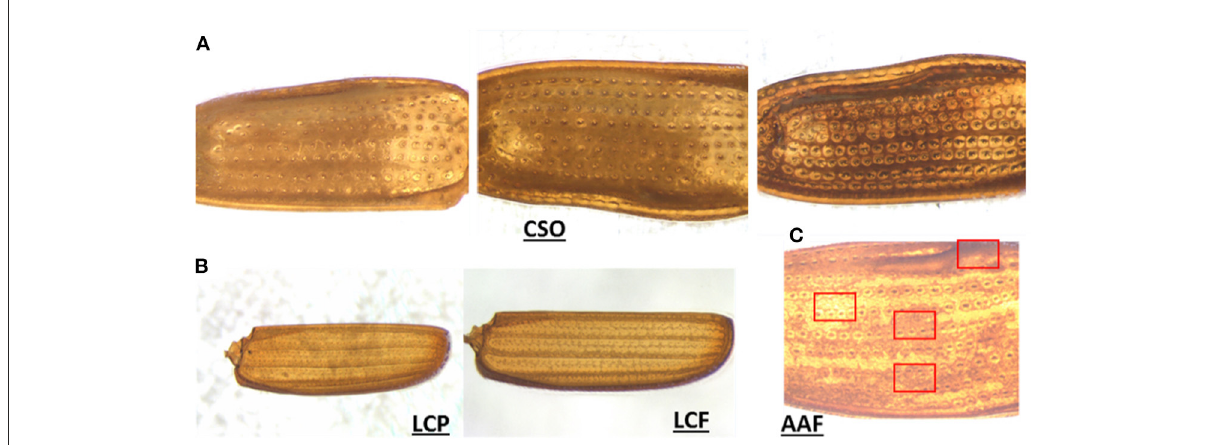
FIGURE6 Representative images of elytral variation. (A) Intraspecies pattern variation in CSO (possibly due to the difference in maturity), (B) pattern variation due to background interference in LCP and LCF, and (C) regional variation in elytral patterns in